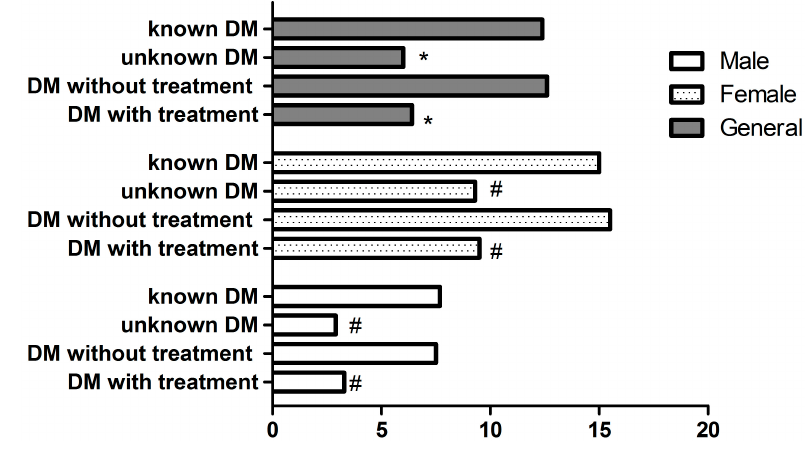
Figure 1. Prevalence of depressive symptoms among those residents known or unknown diabetes and control or uncontrol diabetes. DM: diabetes. * means p < 0.001; # means p < 0.05.